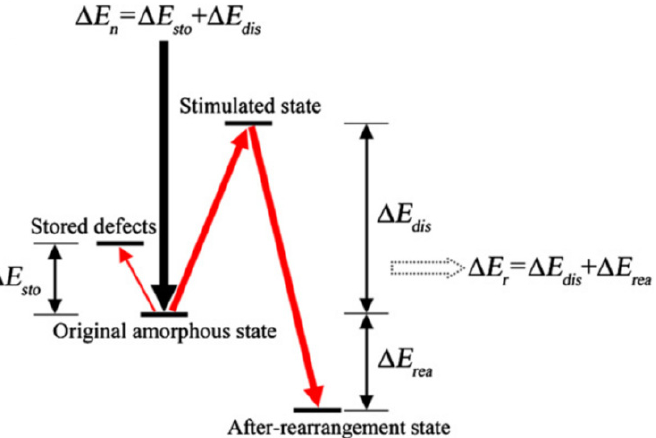
Figure 13. Schematic showing a proposed thermodynamic driven mechanism for the a-to-c transformations in amorphous materials. Reproduced with permission from ref. [69].